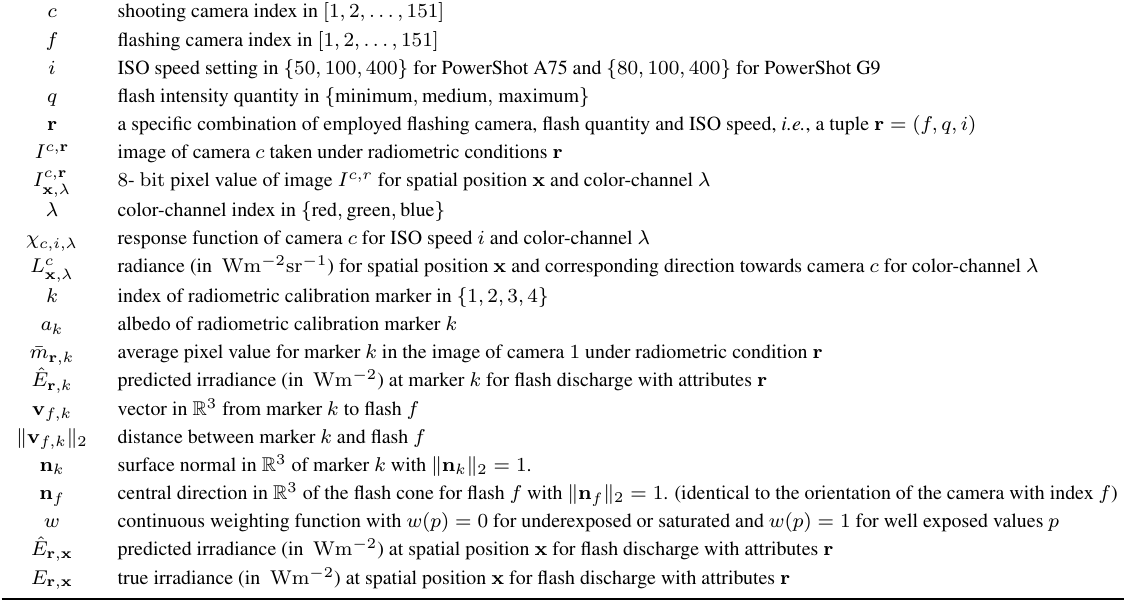
Table 4. Overview of symbols and terms used in the radiometric calibration of the Dome